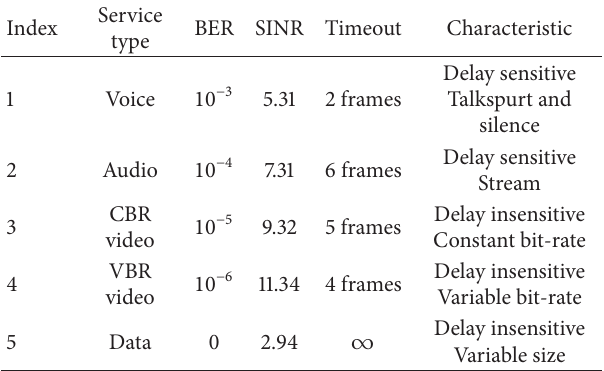
Table 1: Parameters of different traffic types [8].